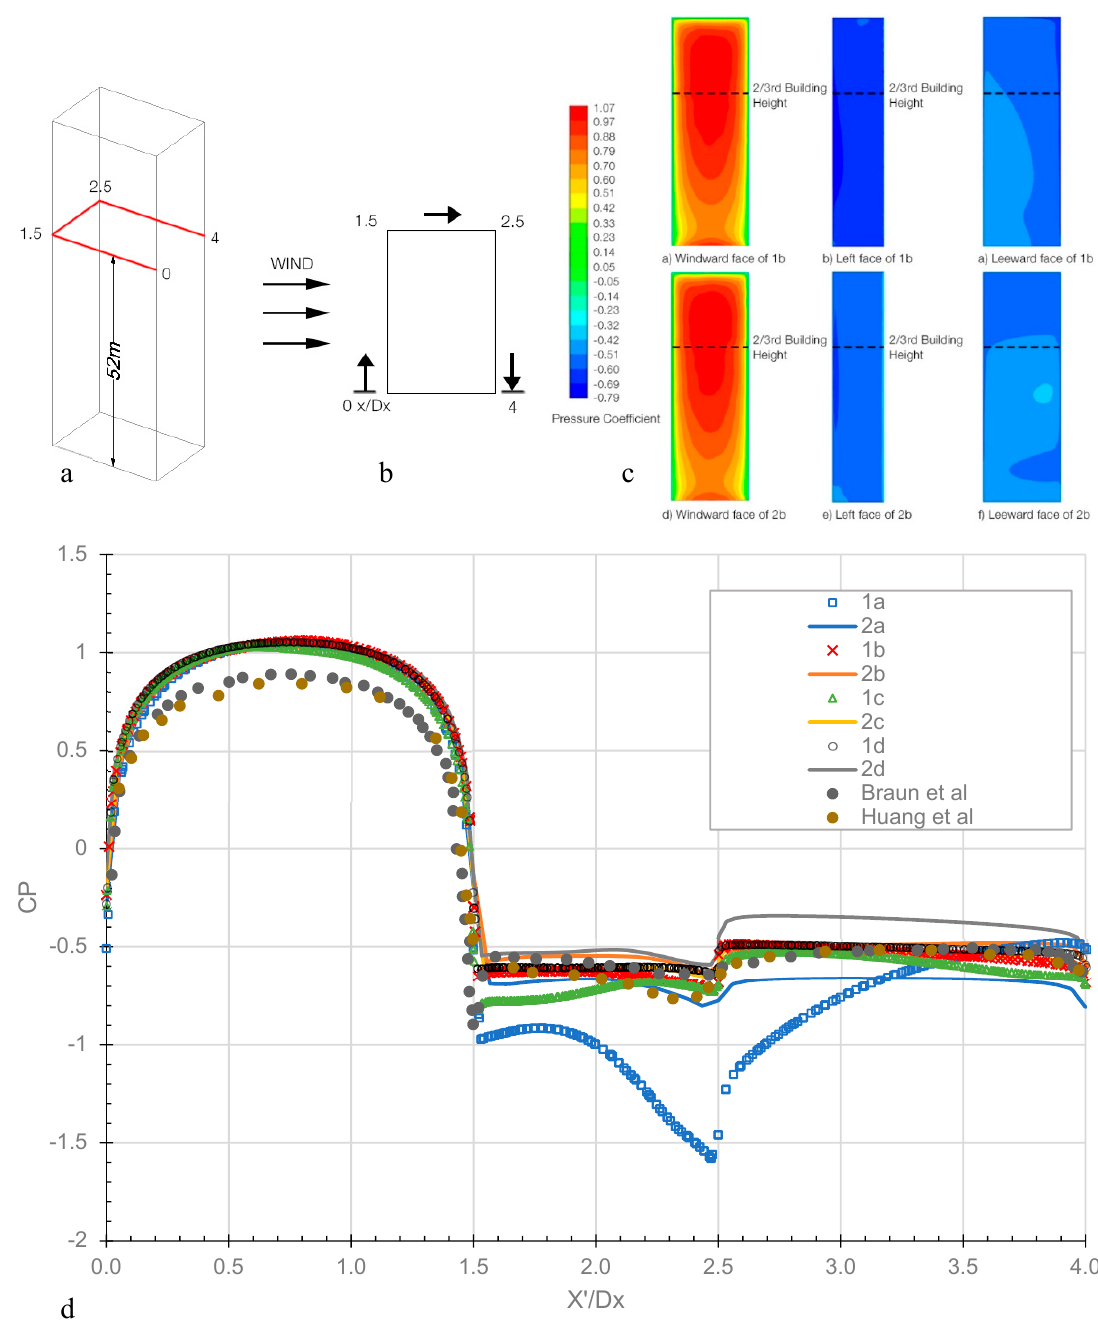
Figure 6. ( a ) Location of the line at which C P was analysed; ( b ) direction of C P evaluation, normalized by building depth; ( c ) contours of C P on building face of models 1b and 2b; ( d ) comparison of C P between present work and previous studies.